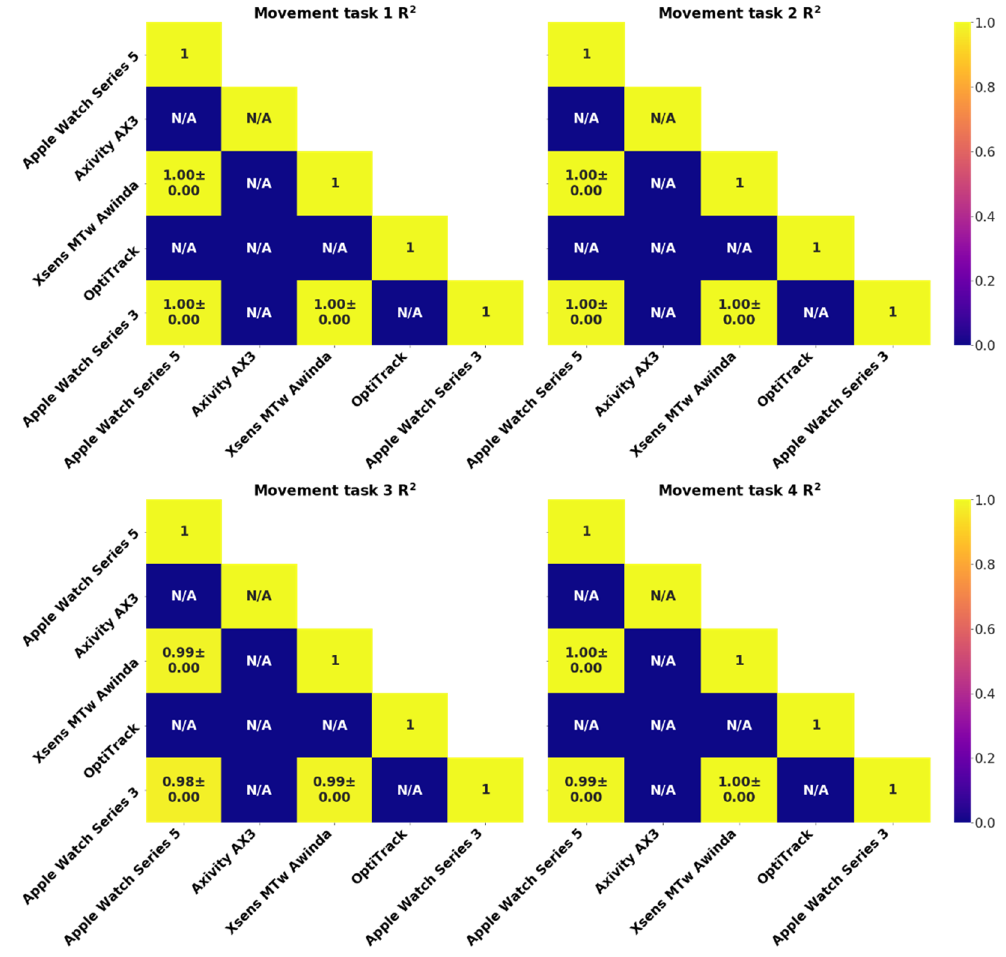
Figure A4 Depicts a breakdown of the angular velocity R2 result in Figure 4c for each of the 4 Figure A4. Depicts a breakdown of the angular velocity R2 result in Figure 5c for each of the 4 movement movement tasks. Displayed R2 in the figure are rounded. tasks. Displayed R2 in the figure are